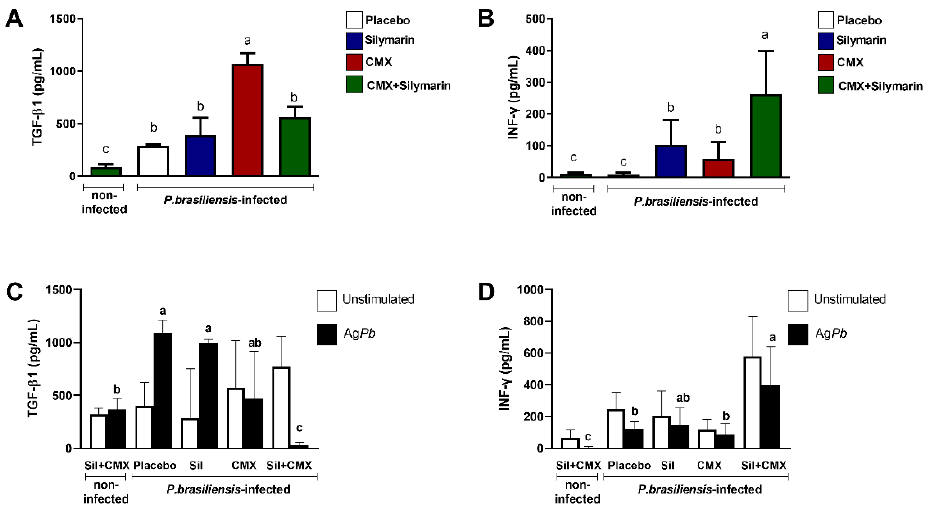
Figure 3. Influence of silymarin in combination with the antifungals cotrimoxazole (CMX) on the quantification of TGF- β 1 ( A ) and IFN-y ( B ) and release of TGF- β 1 ( C ) and IFN-y ( D ) by spleen cells stimulated or not with P. brasiliensis exoantigen. BALB/c mice were infected with P. brasiliensis , and at the 8th week of infection, silymarin/CMX schedule and placebo were started. The mice were evaluated after 12 weeks of treatment. ANOVA with Tukey post hoc test; the values with different superscript letters in a column are significantly different ( p < 0.05); n = 5–7.